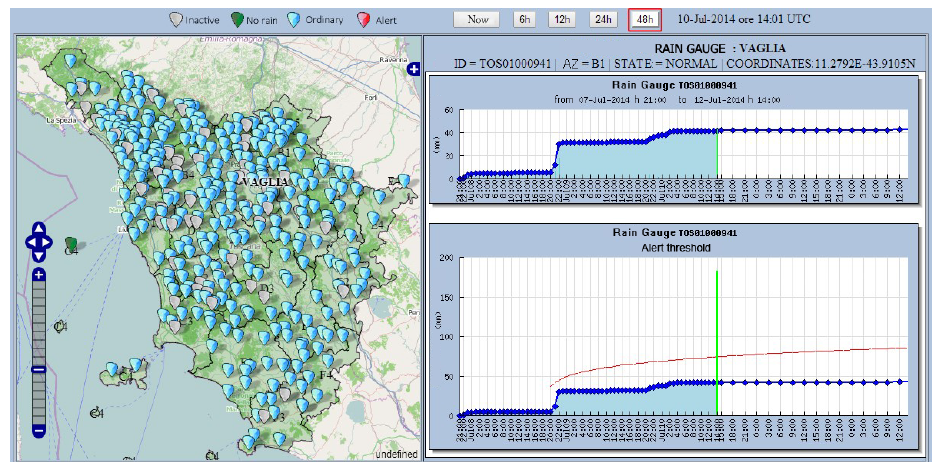
Figure 7. WebGIS interface in the forecasting mode (48h lead time). The green line represents the current time and separates real-time data (left) and rainfall forecasts (right); please note that in this case the highest level of hazard is obtained considering a t_start other than the beginning of the rainfall event.